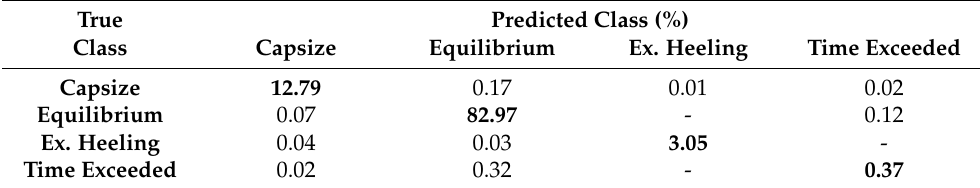
Table 4. Confusion matrix related to ship final fate evaluated at 500